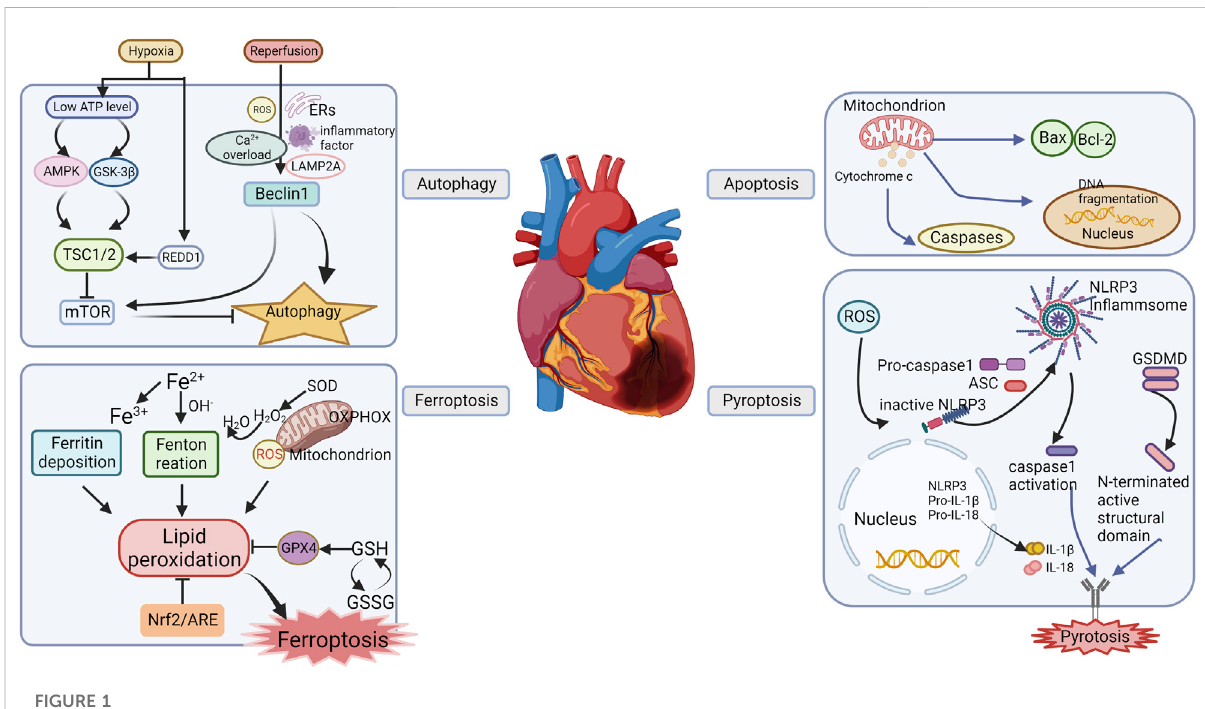
FIGURE 1 Mechanisms of programmed cell death of